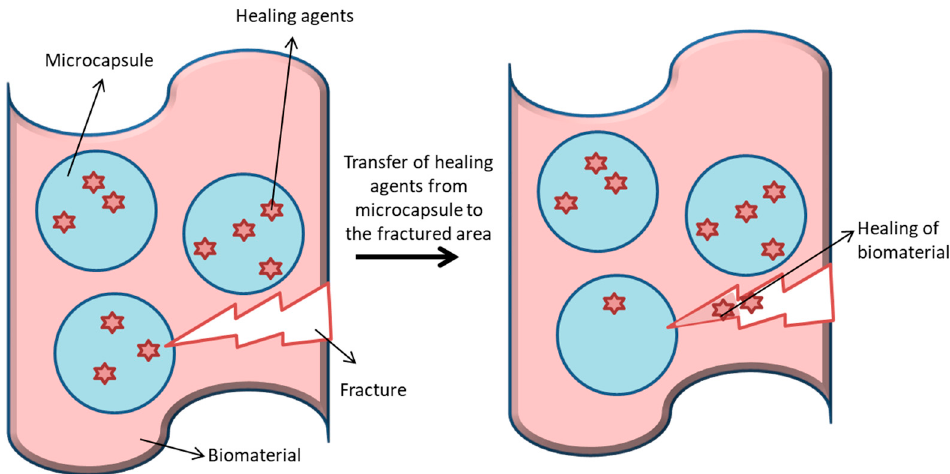
Figure 27. Representation of self-healing property fabricated by using surface engineering technology. The figure shows the fracture of biomaterial surface and the transfer of healing agents from the microcapsule to the fractured area for fast recovery without the requirement of any external stimuli.